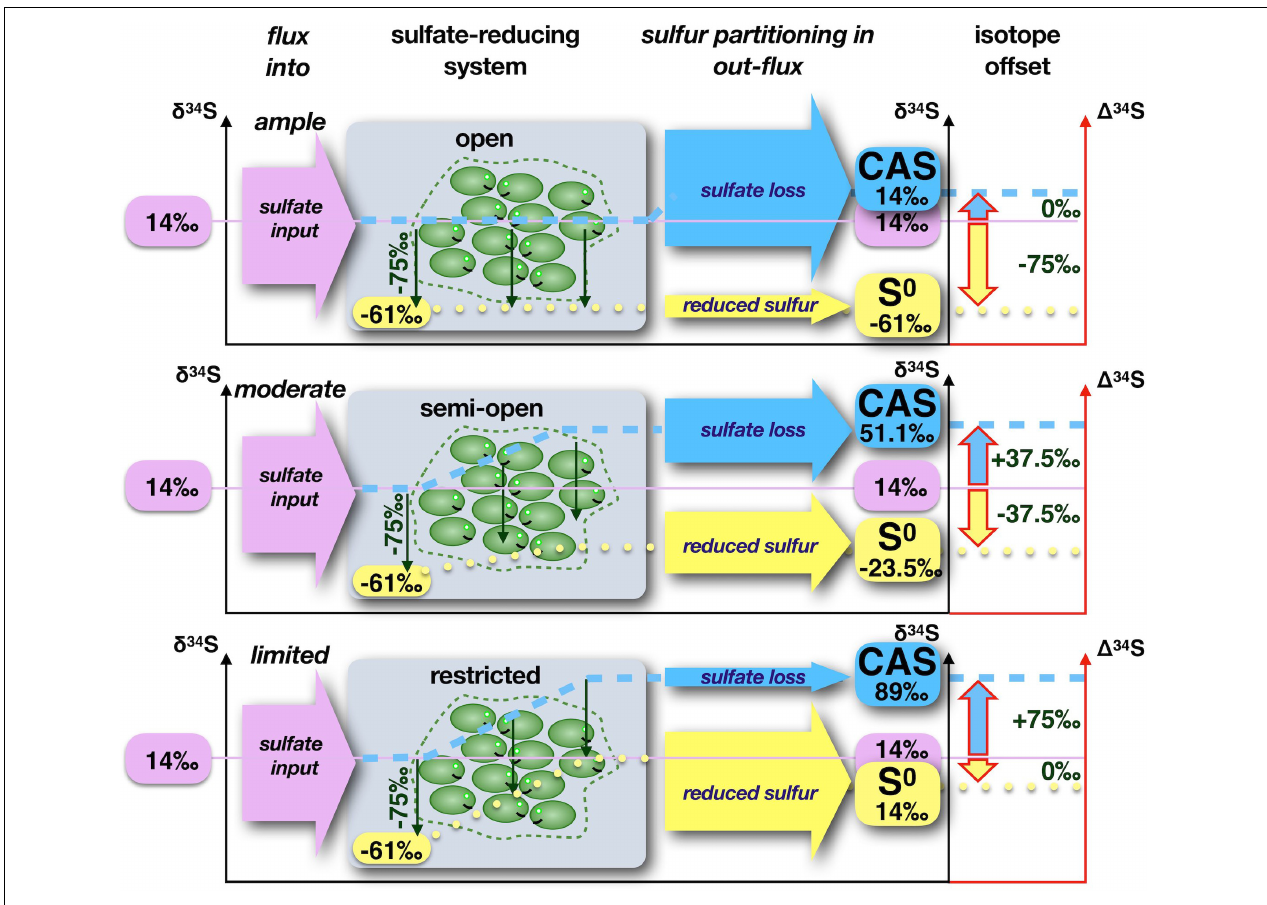
FIGURE 6 | Systems with ample and restricted fluid flow (i.e., removal of sulfate). Examples for sulfur isotope patterns in a system with ample, semi-restricted and restricted fluid flow. The input of sulfate from dissolution of gypsum/anhydrite (chosen δ 34 S of